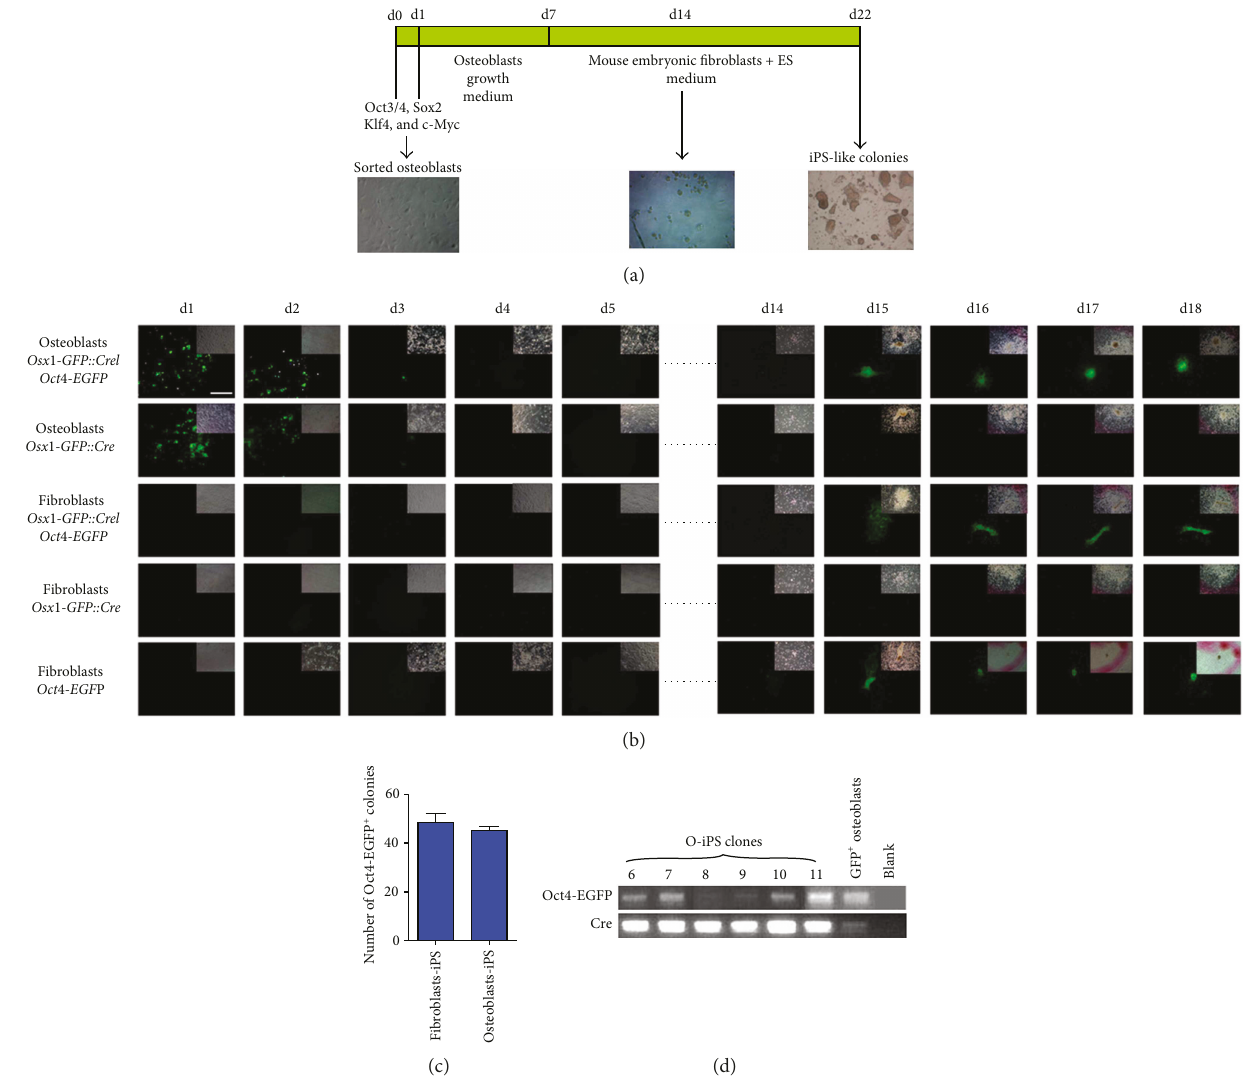
Figure 2: Reprogramming of osteoblasts into iPS cells. (a) Schematic illustration of iPS reprogramming strategy from sorted osteoblasts. (b) Phase (insets) and fl uorescence images of osteoblasts and fi broblasts derived from transgenic mice carrying Osx1-GFP::Cre and/or Oct4-EGFP as well as their respective iPS cells at the indicated day (d) posttransduction. Scale bar: 5 μ m. (c) Quanti fi cation of the number of Oct4-EGFP + F-iPS and O-iPS colonies formed. n = 3 . Data are expressed as means ± SEM. (d) Genotyping of 6 O-iPS colonies for the presence of Oct4- EGFP and Cre transgenes. Sorted GFP + osteoblasts serve as a positive control and blank as a negative